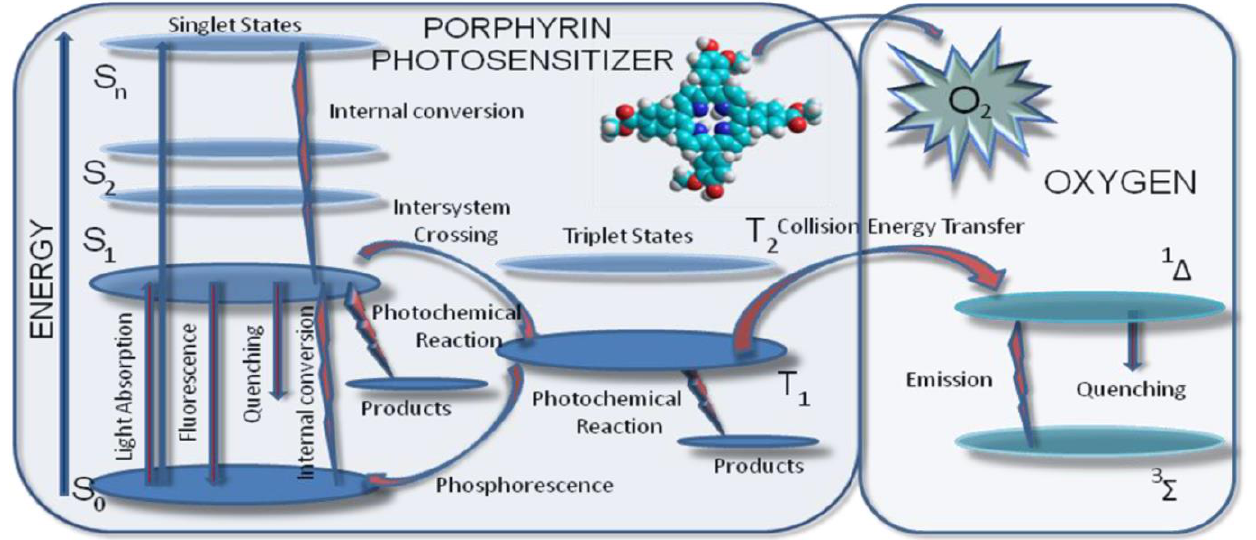
Figure 4. Jablonsky diagram (S 0 − ground state of photosensitizer; S 1 , S 2 , excited singlet states of photosensitizer; T 1 , excited triplet state of photosensitizer).